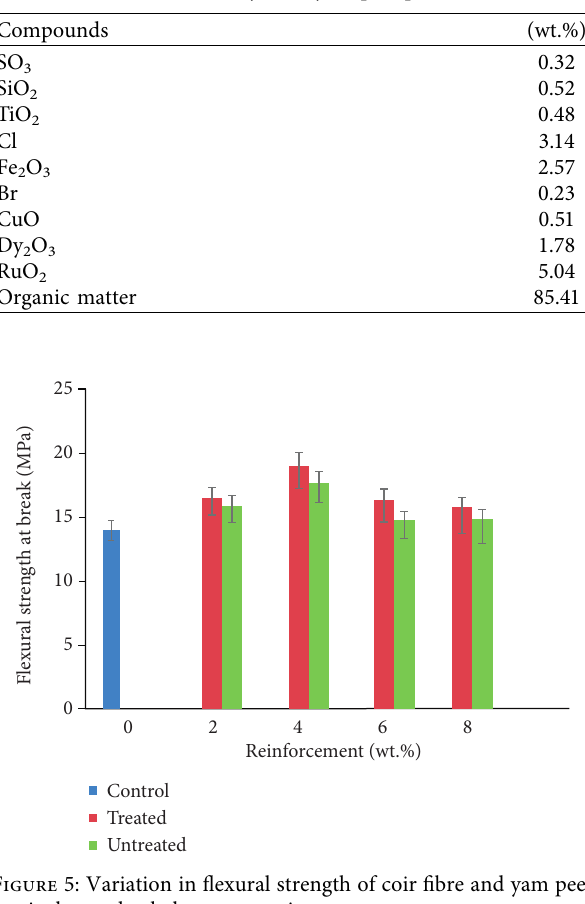
Figure 5: Variation in flexural strength of coir fibre and yam peel particulate polyethylene